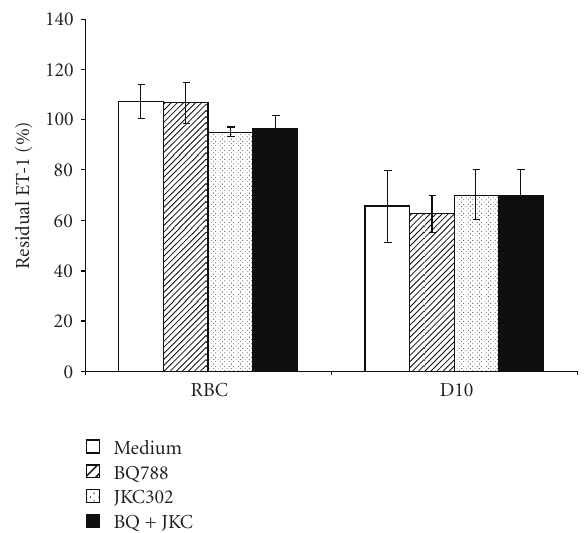
Figure 3: Failure of ET-1 receptor antagonists to inhibit ET-1 removal by pRBC ET-1 (5fmol/mL) was incubated for 24 hours with normal RBC or pRBC (D10) in medium only (empty bars) or in the presence of JKC302, an ET-A receptor antagonist (striped bars) or BQ788, an ET-B receptor antagonist (dotted bars), or in the presence of JKC302 and BQ788 simultaneously. Data are expressed as % of ET-1 recovered in the supernatants and represent the mean ± SD of three di ff erent experiments.